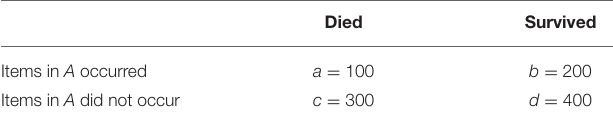
TABLE 2 | A fictional contingency table to show how the OR is calculated. Died